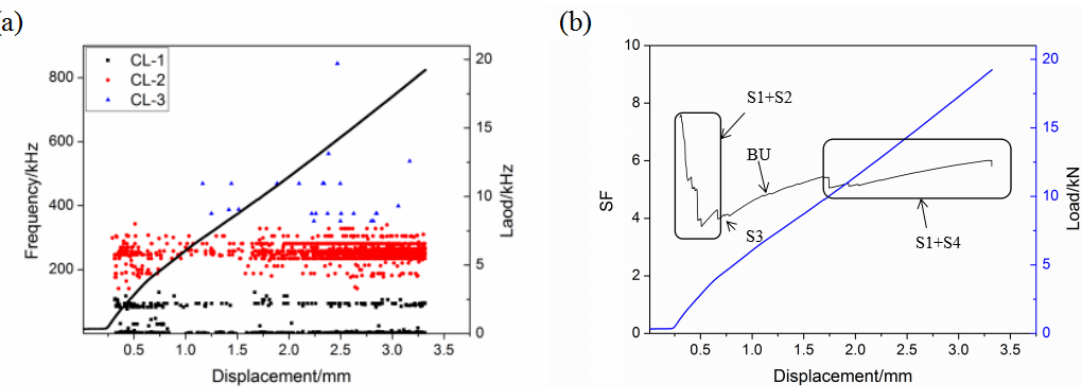
Figure 12. The mechanism-based analysis of AE signals. ( a ) The distribution of frequency regarding the three clusters and ( b ) the SF diagram associated with the applied tensile load.